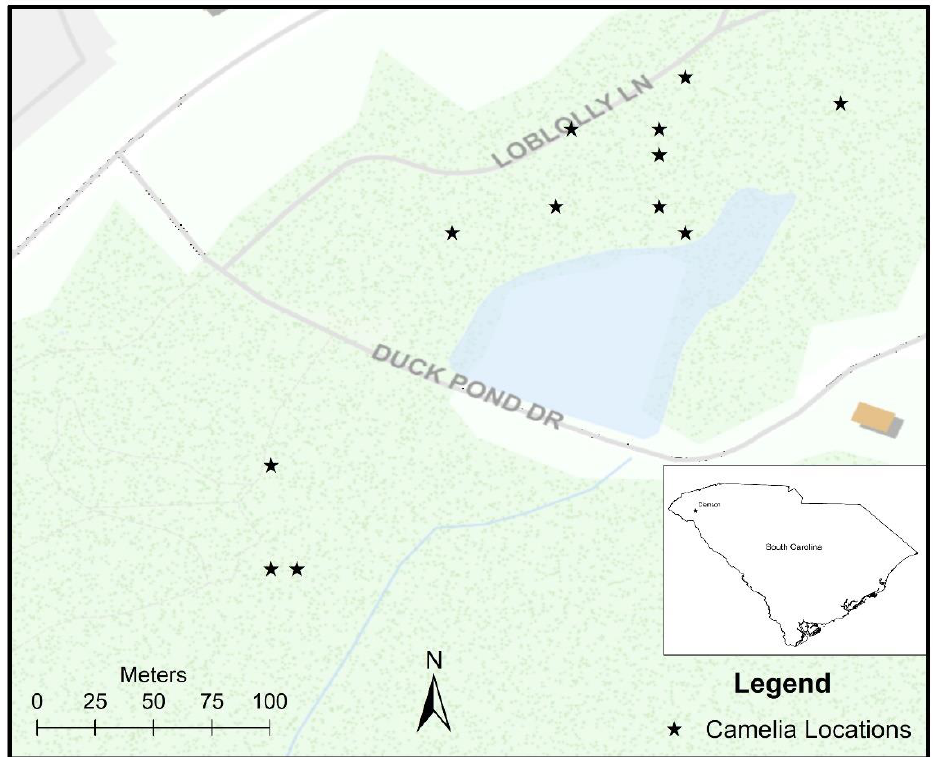
Figure 1. Map of the study area and sampling locations in the South Carolina Botanical Garden in Clemson, SC, USA.